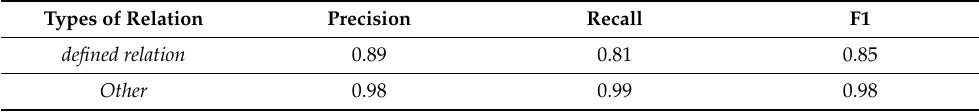
Table 6. Binary relation